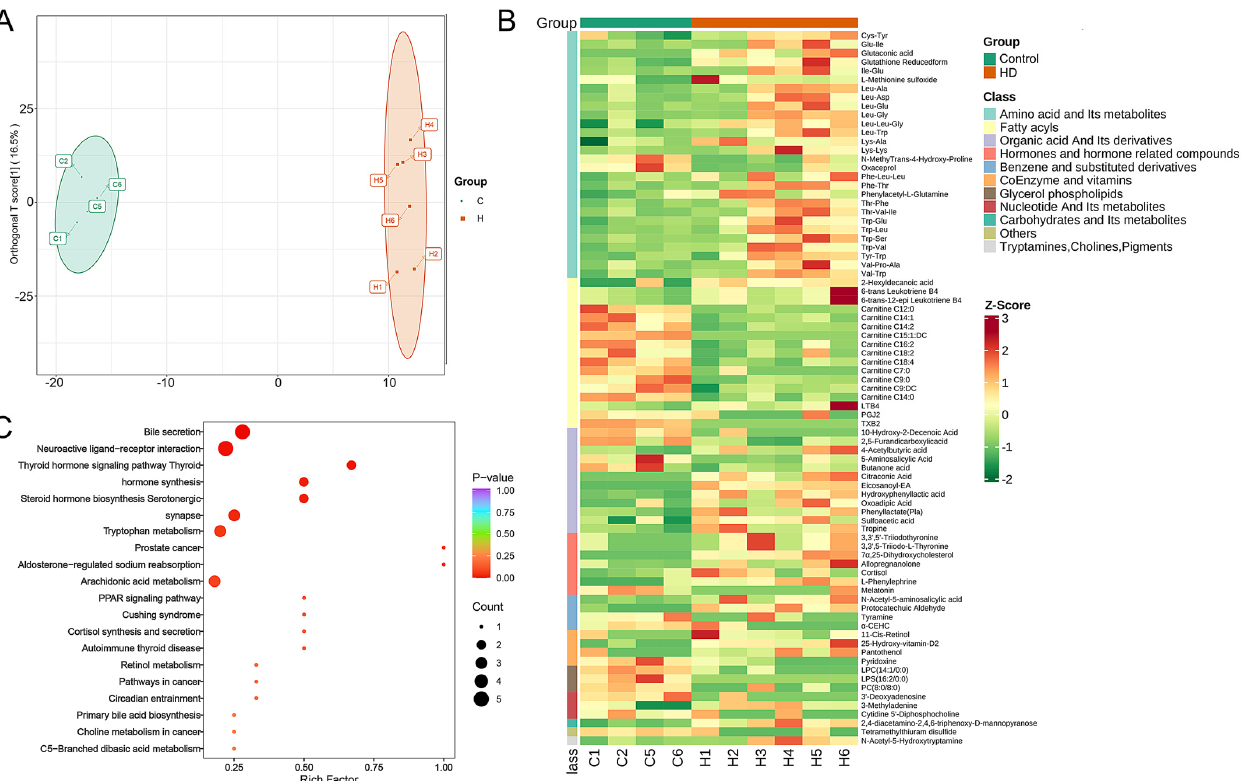
Figure 4. Differences between control and HD groups in gut metabolite composition of zebrafish. ( A ) OPLS-DA score plot of control and HD groups. ( B ) Heat map showing the differential metabolites in different categories, with the leftmost column showing the categories in different colors. ( C ) Bubble diagram of KEGG enrichment results of differential metabolites.